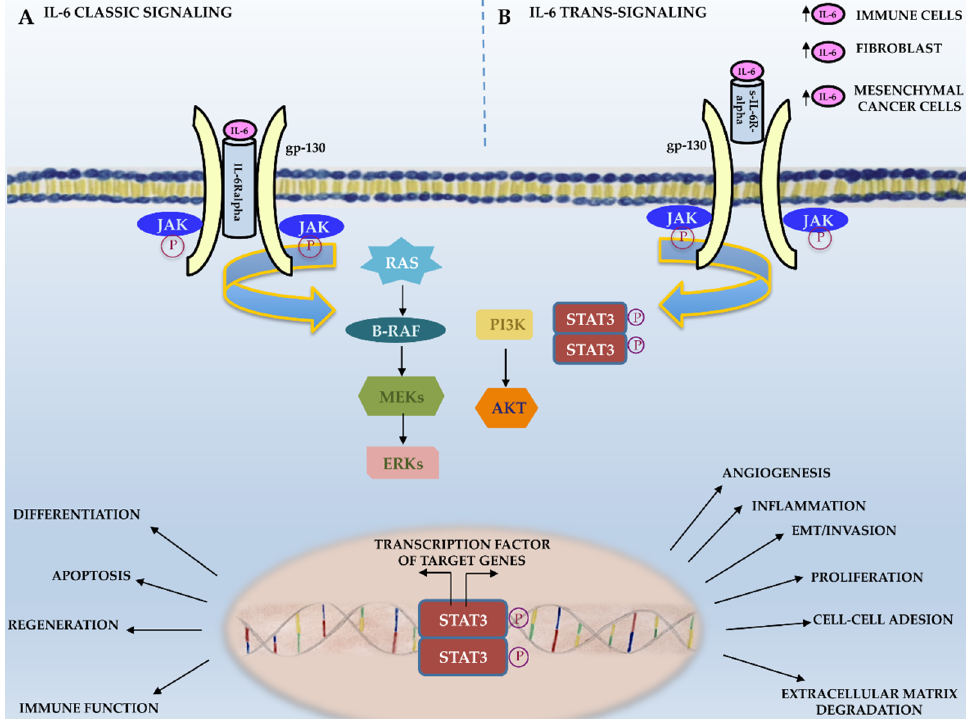
Figure 2. IL-6 signaling. Schematic representation of IL-6 classic and trans-signaling.